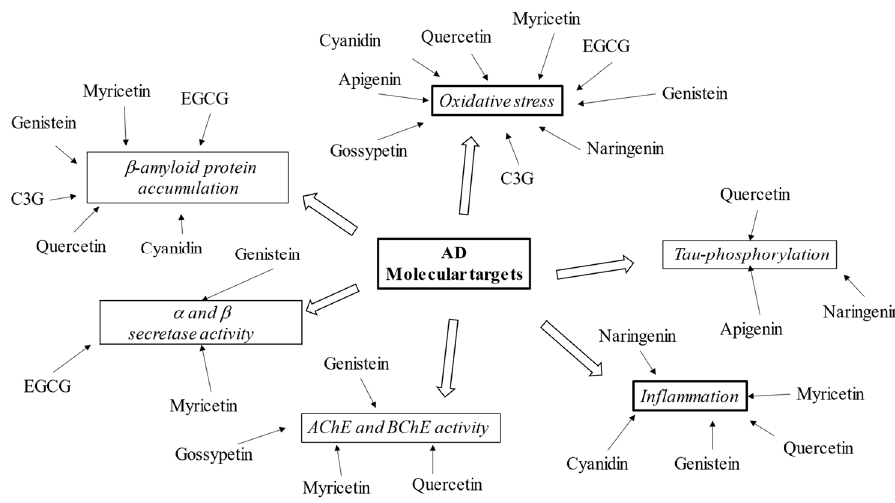
Figure 3. Schematic effects of described flavonoids on molecular targets of AD.